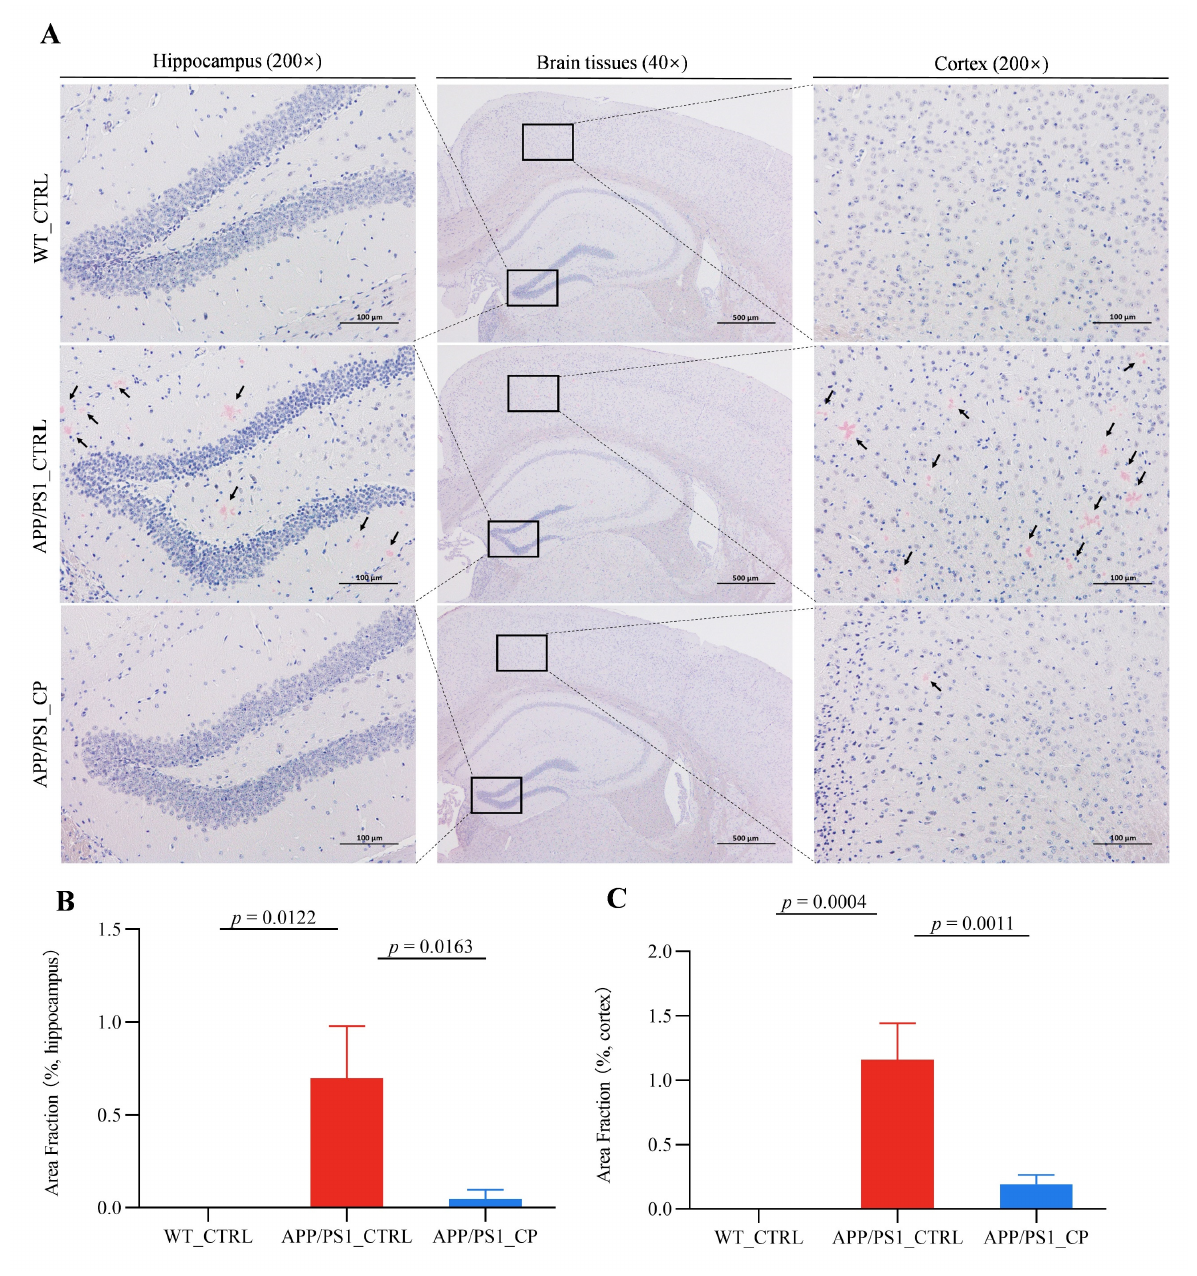
Figure 2. Capsaicin reduces β -amyloid plaques deposits of brain tissues in APP/PS1 mice (all groups: n = 4). ( A ) Representative images of brain tissues using Congo red staining in all mice (arrows label A β plaques). ( B , C ) represent the deposits of β -amyloid plaques in the hippocampus and cortex. Results are mean ± SEM. The minimum significance value was considered as p < 0.05.